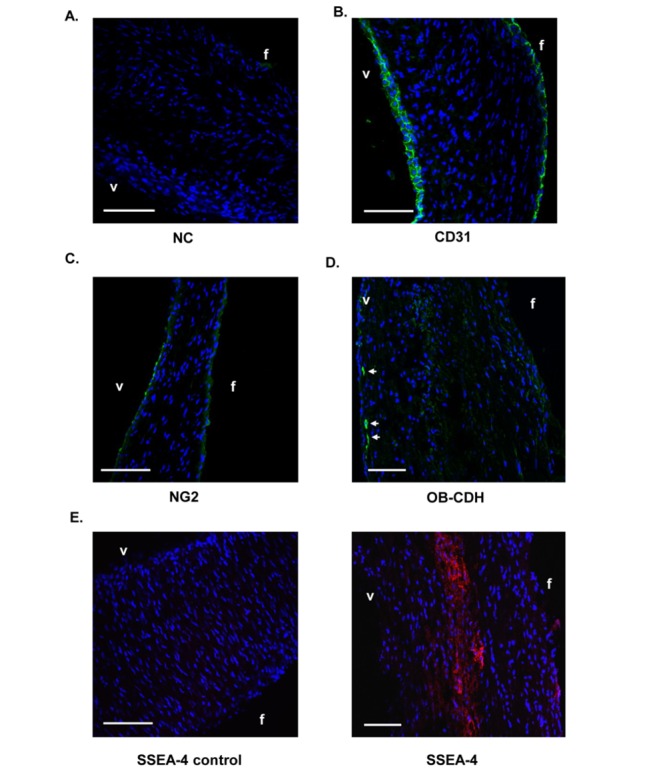
Localization of certain pVIC subpopulations in native porcine valves.Immunostaining of multiple VIC subpopulation markers was carried out on aortic valve sections. v: ventricularis side. f: fibrosa side. (A) Negative control (NC) which has been incubated with secondary antibody only and serves as a control for panels B–D. (B) CD31 staining (green) localized to the valve surfaces. Interestingly, some surface regions had multiple layers of CD31+ endothelial cells. (C) NG2 staining (green) was found at the edge of the valves. (D) OB–CDH stained clusters of pVICs on the ventricularis side of the aortic valves (green, arrows). (E) Compared with control, SSEA-4 staining (red) was primarily in the middle of the valves.